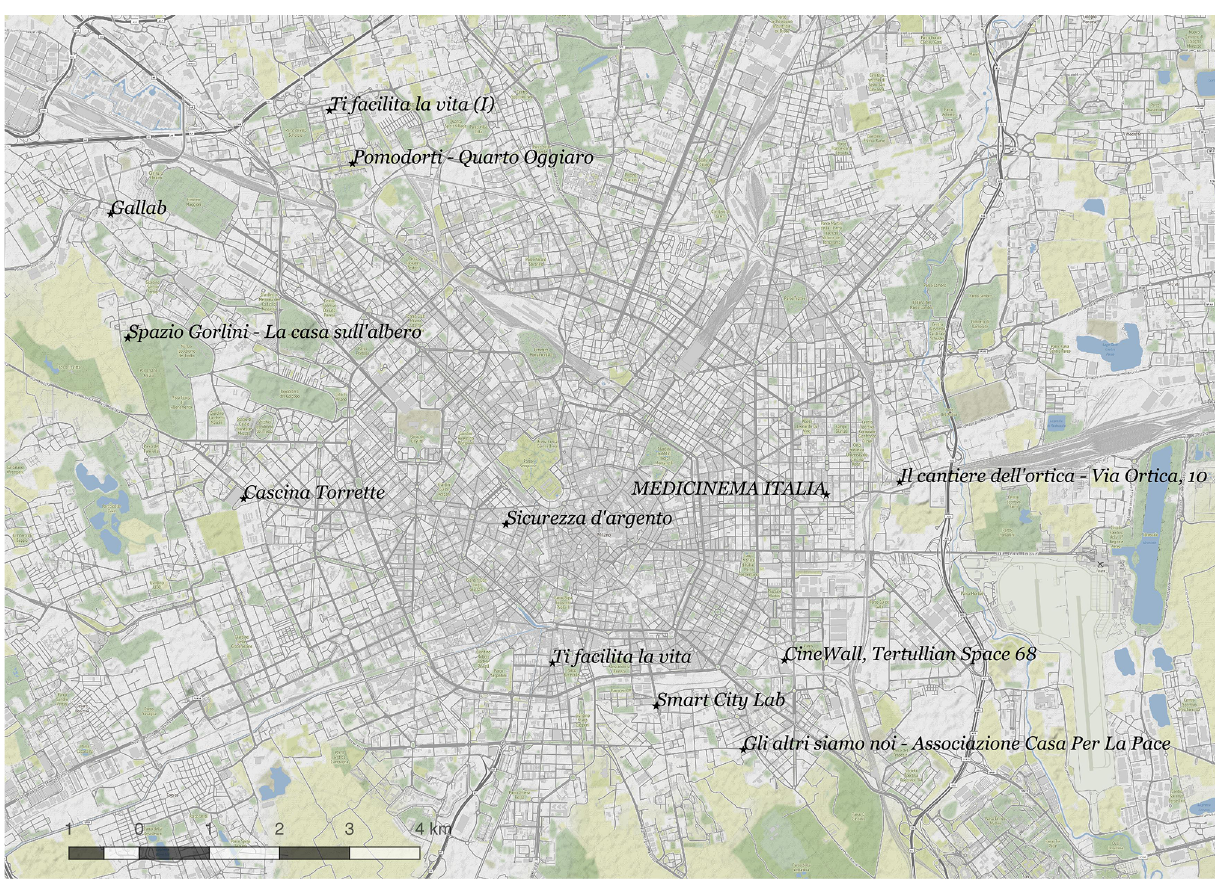
Figure 1. Civic crowdfunding realised projects in Milan, 2018. Source: